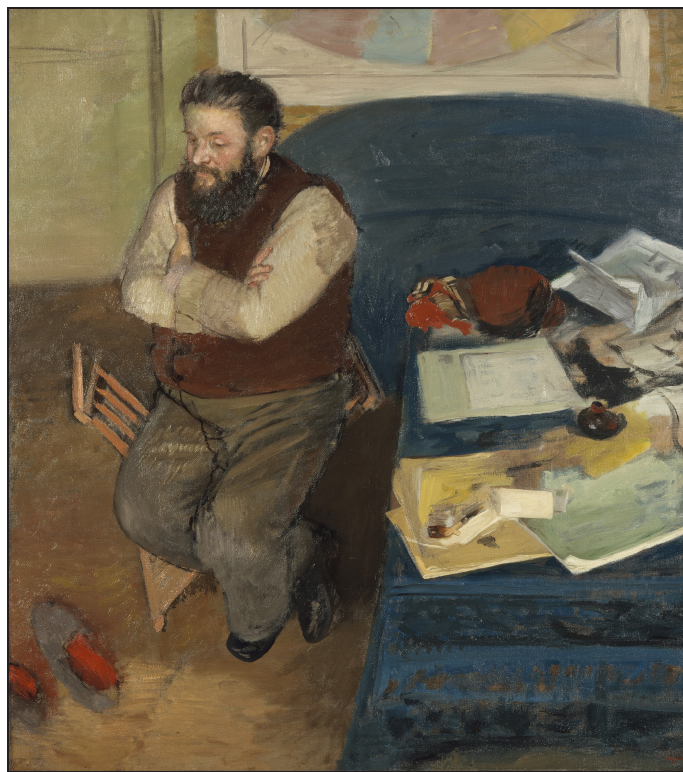
Fig. 4 : Edgar Degas, Diego Martelli (1839–1896) , 1879, oil on canvas, 110.4 × 99.8 cm, National Galleries of Scotland,